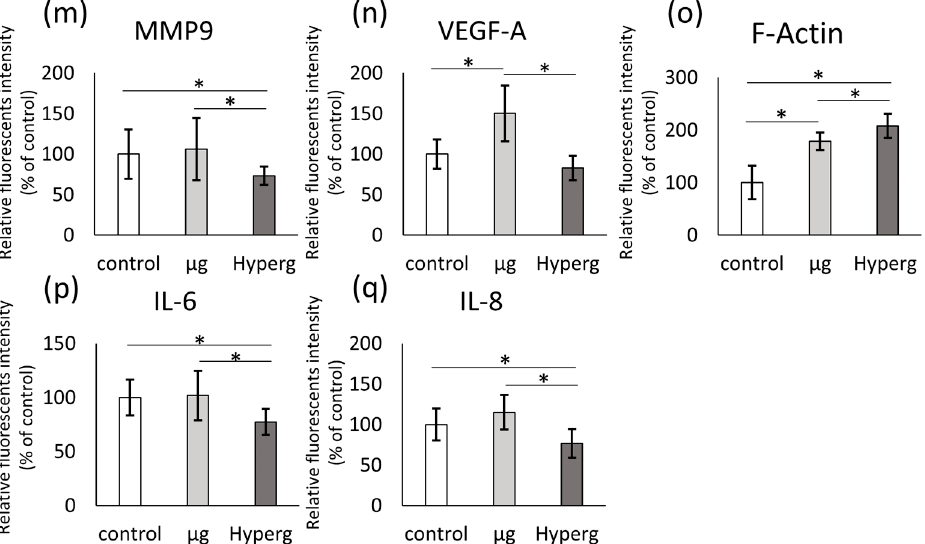
Figure 2. Indirect immunofluorescence staining of PFA-fixed cells from the TEXUS 54 sounding rocket mission. 2500 MCF-7 cells were seeded into each well of the 18 well Ibidi slides. The cells were fixed either at the end of the hyper- g period or at the end of the µ g period. The two conditions were compared to 1 g -ground control samples. The confocal laser scanning microscopy images ( a - l ) show either MMP9, VEGF-A, IL-6 or IL-8 in green, DAPI (in blue) and F-Actin (in red). Scale bar is equal to 50 µm. The intensity of the staining was quantified by ImageJ ( m - q ). All data are shown as mean ± SD, n = 10–14, with significance indicated by * p < 0.05.